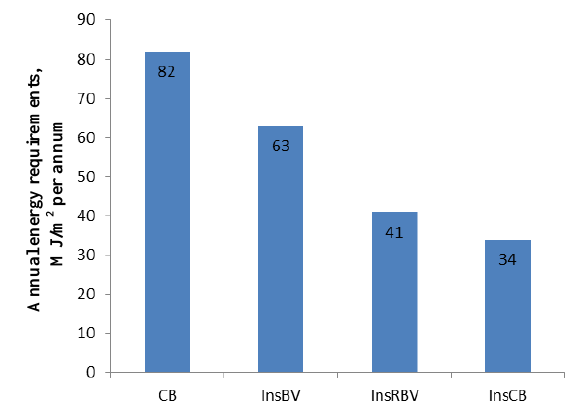
Fig. 4. Annual energy requirements for all the